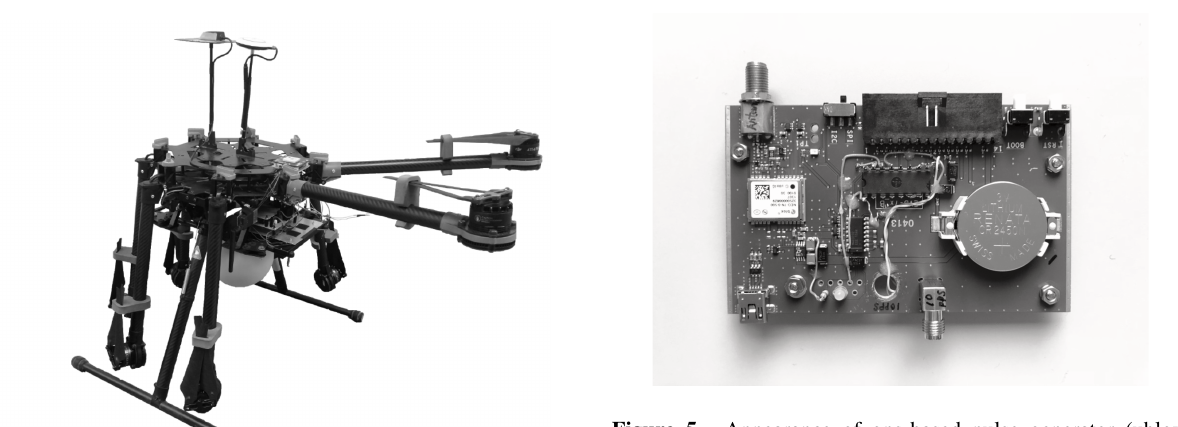
Figure 5. Appearance of gps-based pulse generator (ublox,